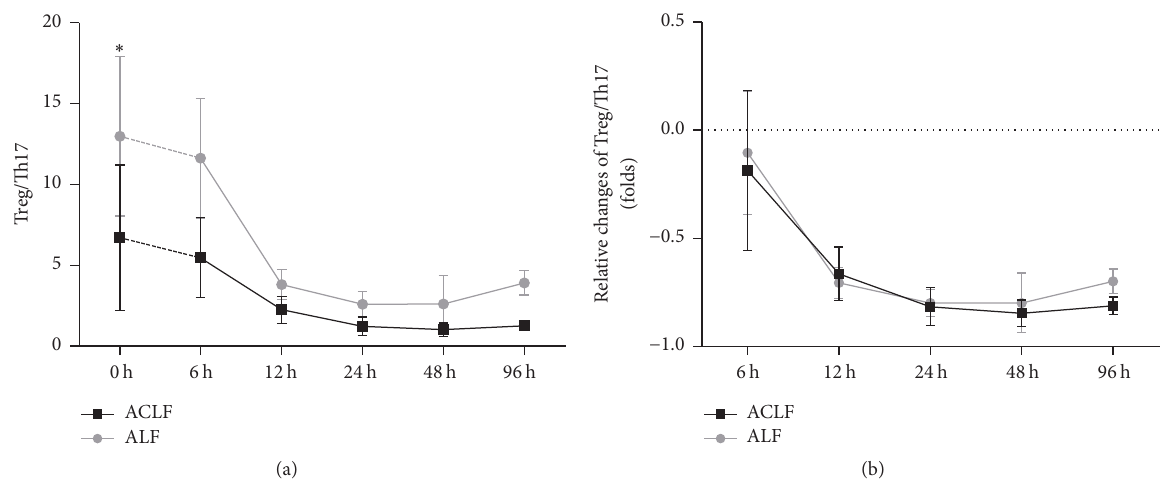
Figure 6: Change of Treg/Th17 ratio. (a) Treg/Th17 ratio in ACLF group and ALF group. (b) Relative changes of the ratios; ∗ 𝑝 < 0.05